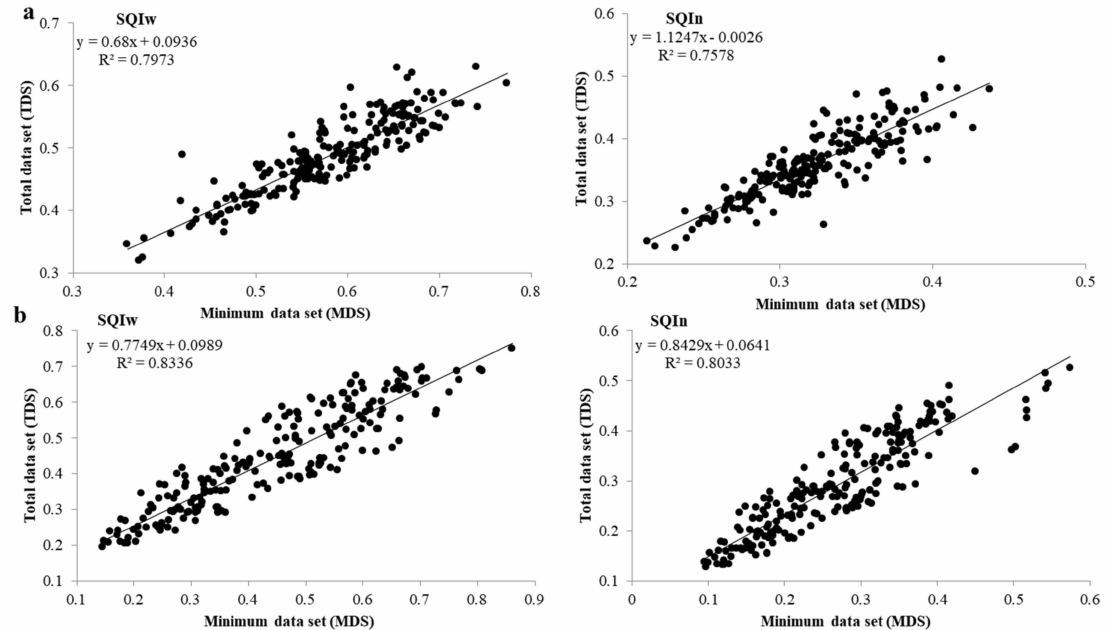
Figure 4. Linear relationships between soil quality indices ( SQI n —nemoro soil quality index; and SQI w —weighted additive soil quality index) were calculated using the total data set (TDS) and minimum data set (MDS) approaches by ( a ) linear scoring and ( b ) nonlinear scoring